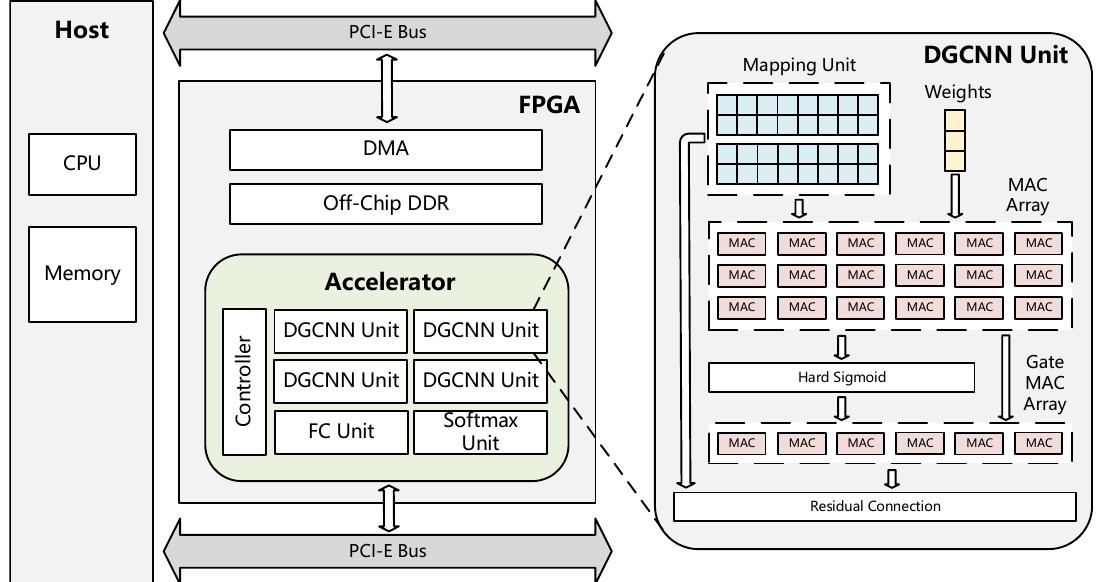
Figure 6. Overall architecture of our accelerator ( left ) and Dilate Gated Convolutional Neural Network (DGCNN) unit ( right